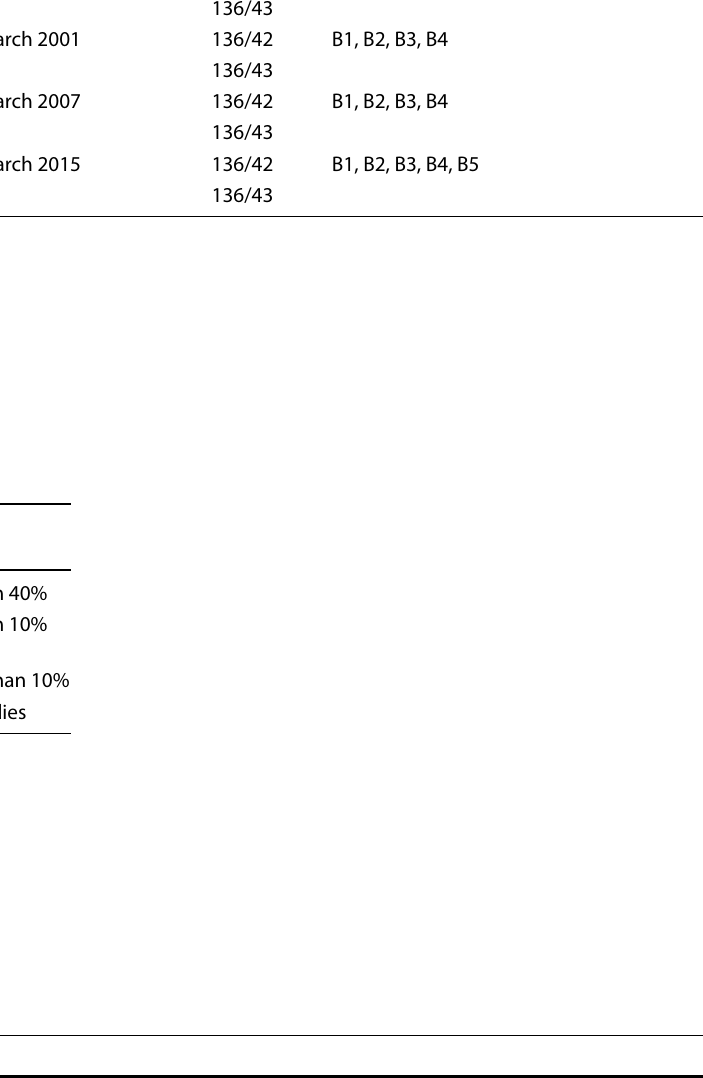
Table 10 Description of satellite data used for the present study